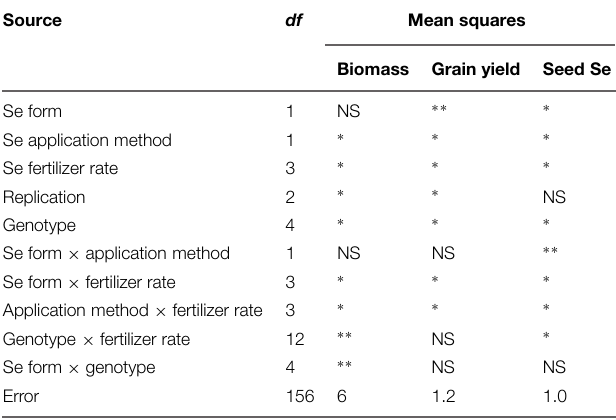
TABLE 1 | Combined analysis of variance for lentils grown with different Se fertilizer forms, application methods, and rates under greenhouse conditions.